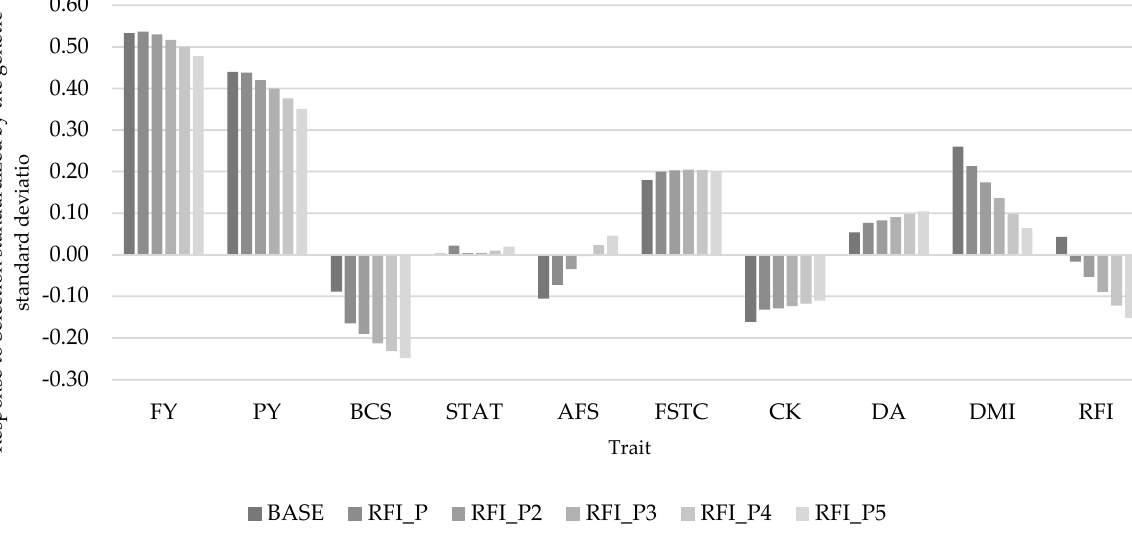
Figure 3. Response to selection for scenarios with different weights on RFI by trait standardized by the genetic standard